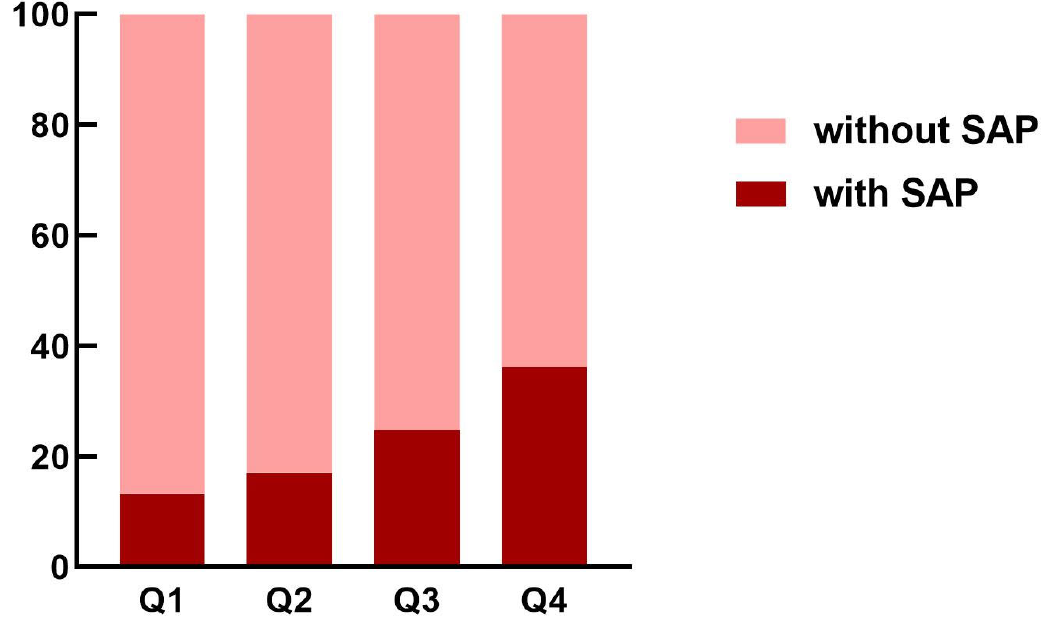
Figure 3. The proportion of SAP in acute ischemic stroke patients according to the quartiles of HMGB1 concentrations. HMGB1, high ‐ mobility ‐ group box 1; SAP, stroke ‐ associated pneumonia. Table 2. Odds ratio and 95% confidence interval of SAP according to HMGB1 among acute ischemic stroke patients. HMGB1 as a Categorical Variable HMGB1 as a